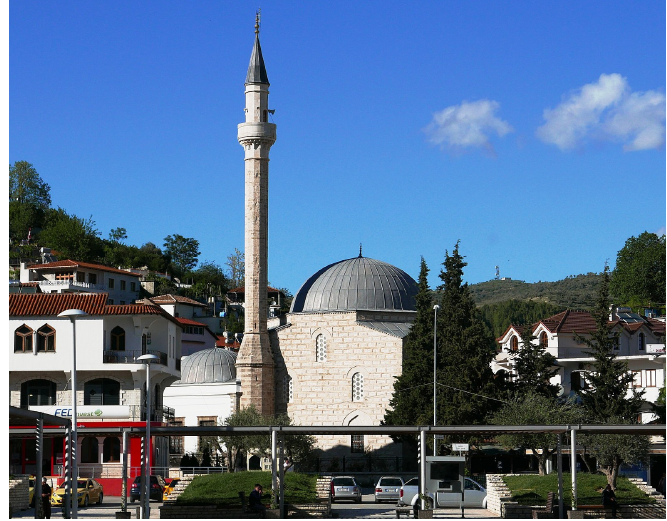
Figure 6. View of the Lead Mosque of Berat [10].